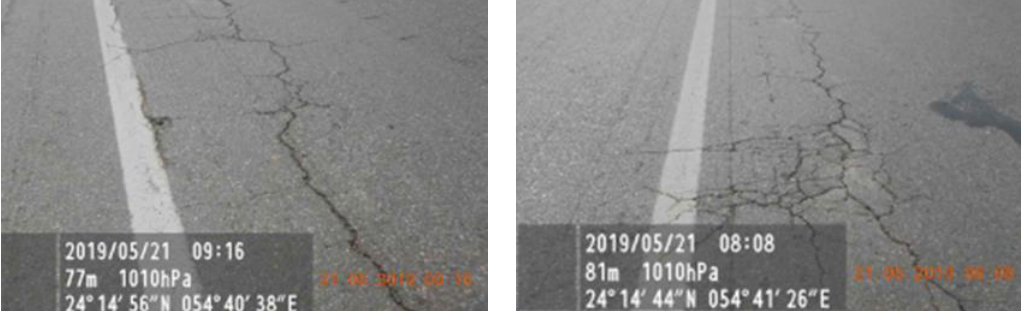
Figure 1. Field survey of the existing pavement structure.